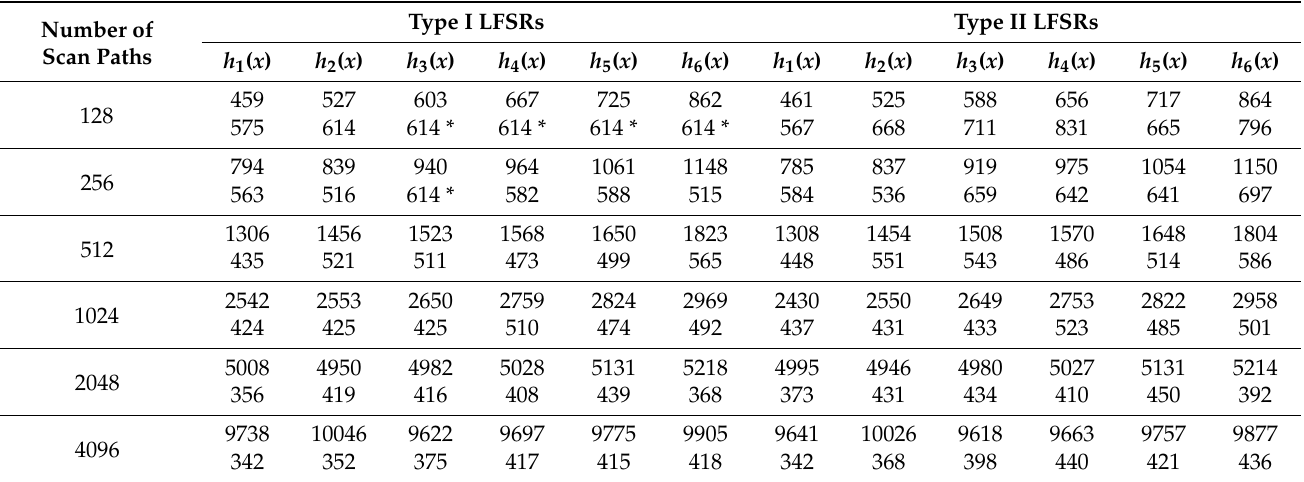
Table 9. Implementation costs and maximum operation frequencies for test pattern generators of the LFSR + PS type disclosed in [34].